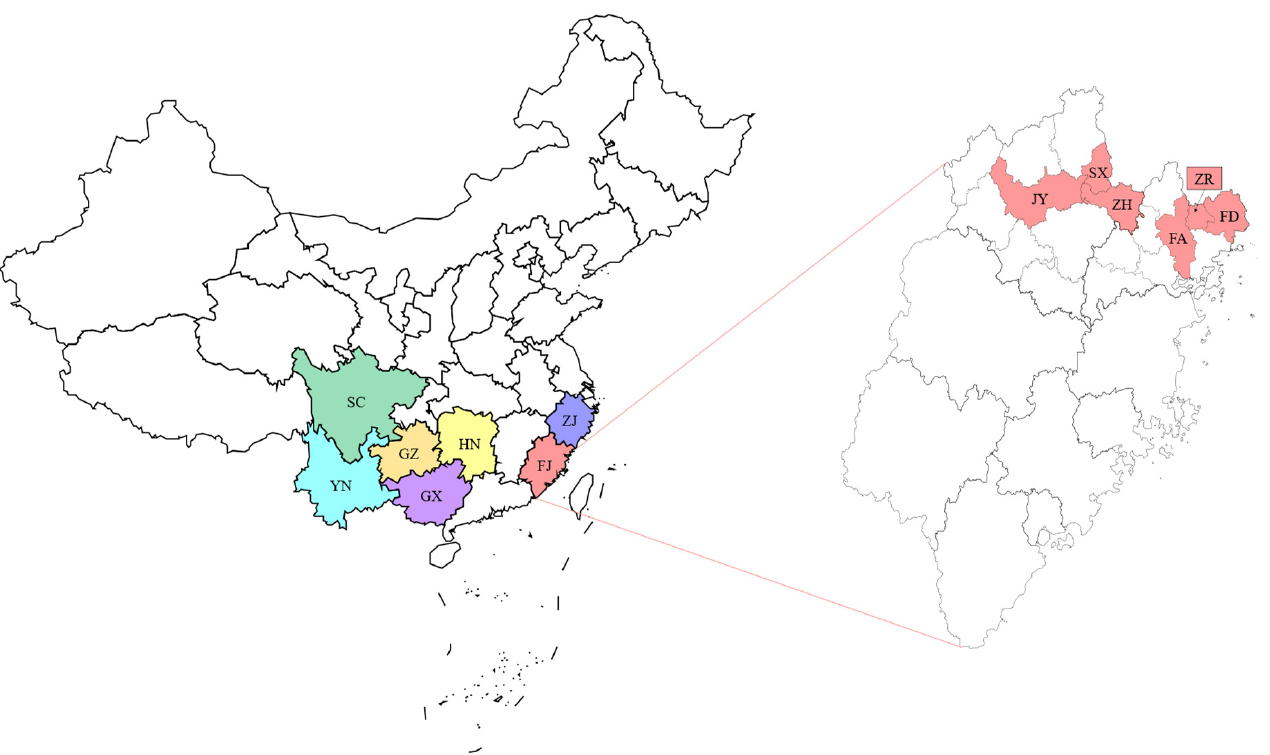
Figure 1. Sampling locations of white tea samples. (On the left is the geographical locations of seven different provinces in China, including FJ, GZ, HN, SC, YN, ZJ and GX; on the right is the portion zooming in to show the white tea production districts in Fujian Province, including FD, FA, ZH, SX, JY and ZR).